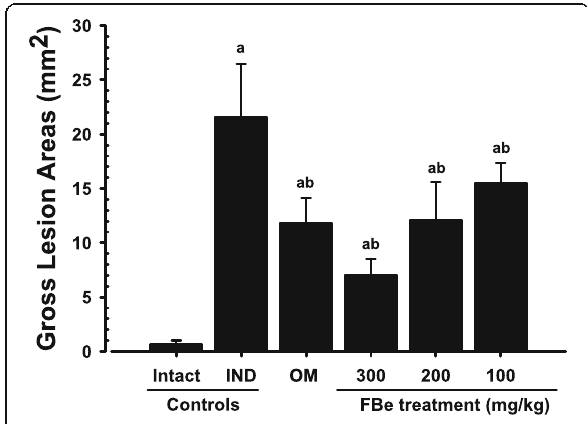
Fig. 3 Gross lesion areas on the gastric mucosa, taken from intact or IND-treated rats. Values are expressed as mean ± S.D. of eight rats, mm 2 . FBe: triple fermented barley extract as test material; IND: indomethacin; OM: omeprazole. All test substances were single orally administered, at 30 min before IND 25 mg kg − 1 single oral treatment, and all animals were sacrificed at 6 h after IND treatment. a p < 0.01 as compared with intact control by MW test. b p < 0.01 as compared with IND control by MW test